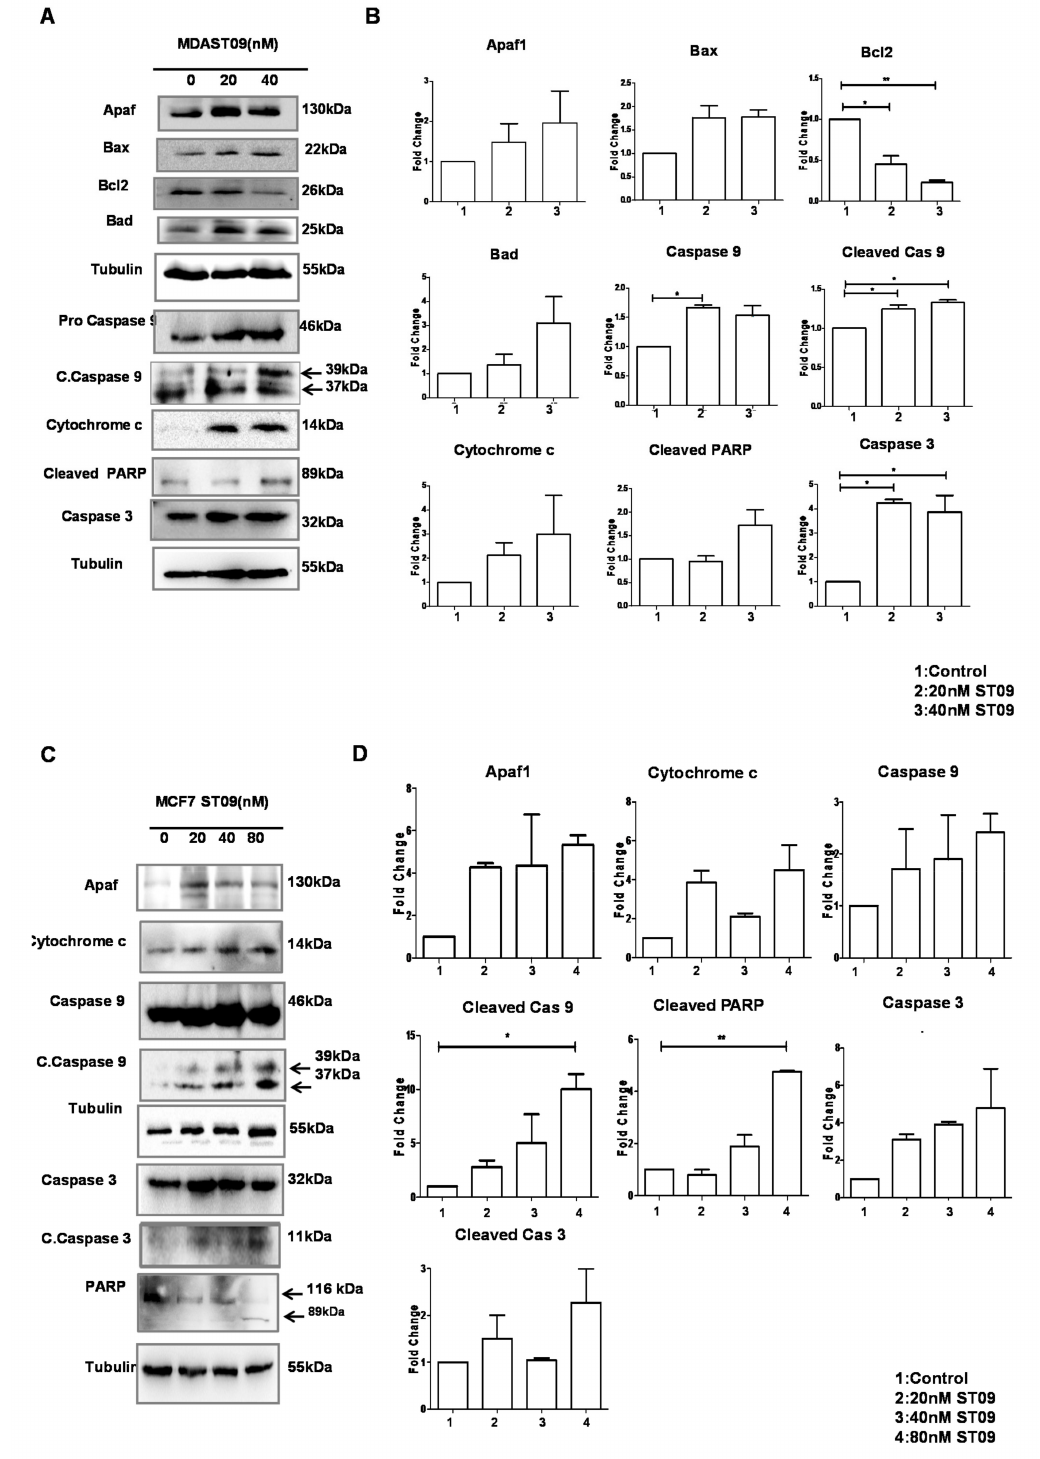
Figure 6. Assessment of apoptotic proteins in breast cancer cells treated with ST09. Western